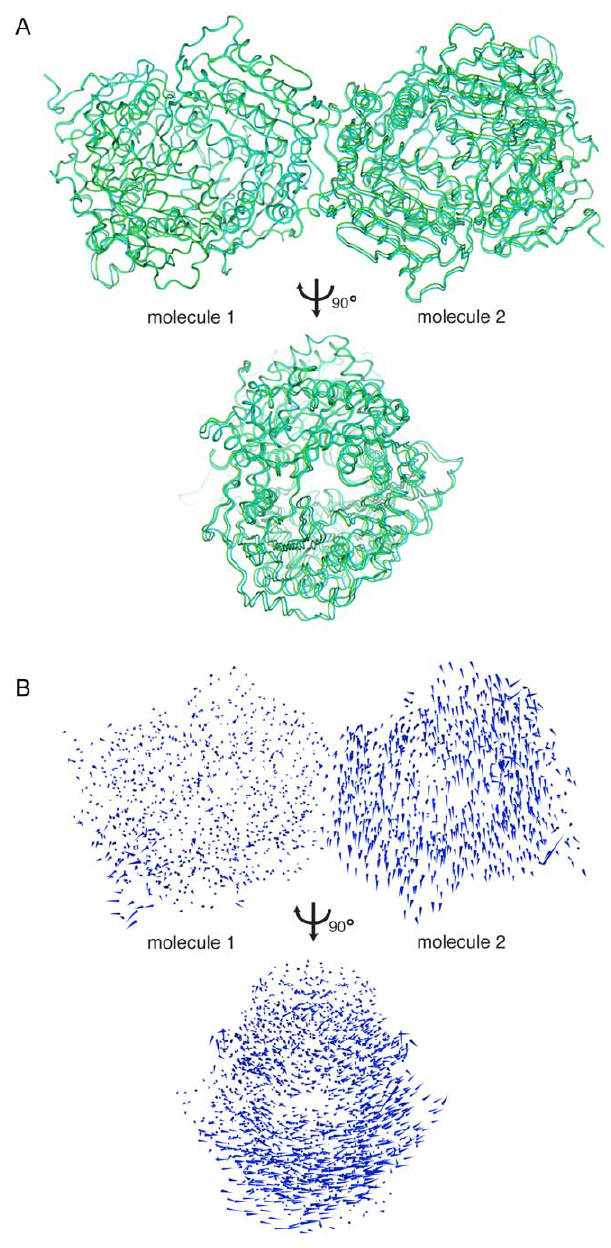
Figure 6. Changes at the dimer interface. (A) Superimposed dimer structures of unliganded IDE (green) and rIDE-E111F with peptide ligand bound at the active and distal sites (cyan). Dimers are aligned based on C a positions of one monomer (molecule 1). (B) Porcupine type representation of the change in C a positions between the two structures aligned on molecule 1. Cones represent the magnitude and direction of C a positional changes. The size of the cones has been scaled by a factor of 2.5 relative to the dimensions of IDE to emphasize the conformational shifts. The orientations of the molecules are the same as those in panel